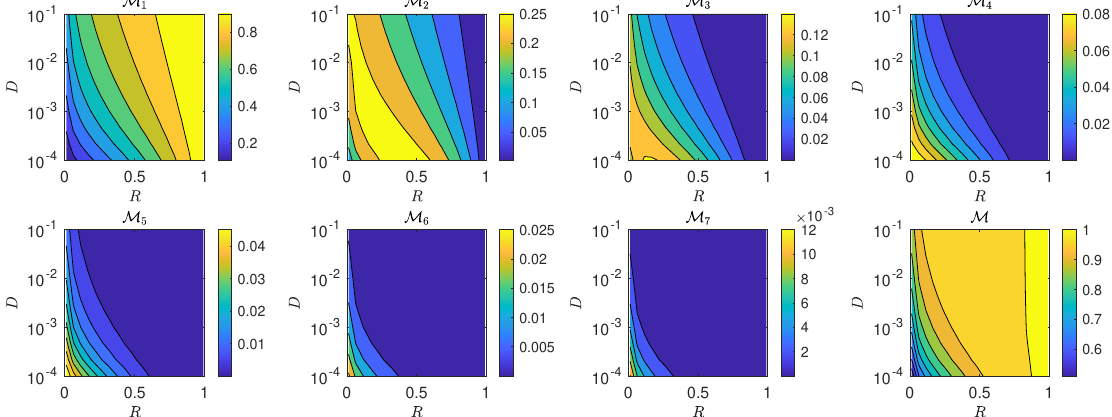
Figure 10. Night-by-night and total mating probabilities for the hat calling strategy. Note the different likelihood scales for each panel. Similar to Figure7, intermediate-quality moths (medium { R , D } ) display relatively large mating likelihoods M (cid:96) on the second and successive